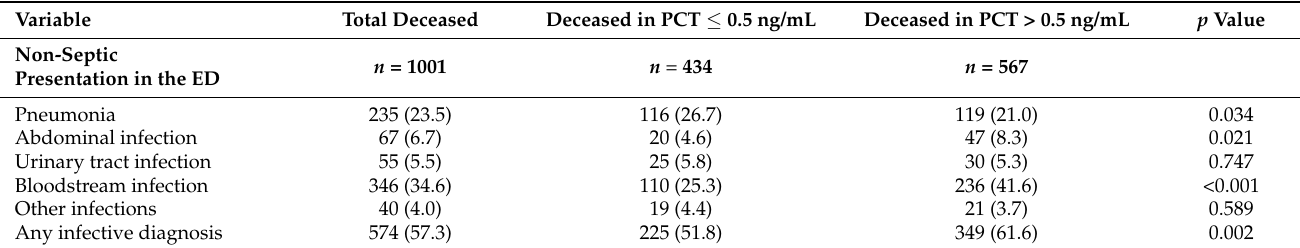
Table 4. Outcomes of patients in the study cohort for non-septic presentation in ED (qSOFA <2) according to PCT value at admission and discharge diagnosis.